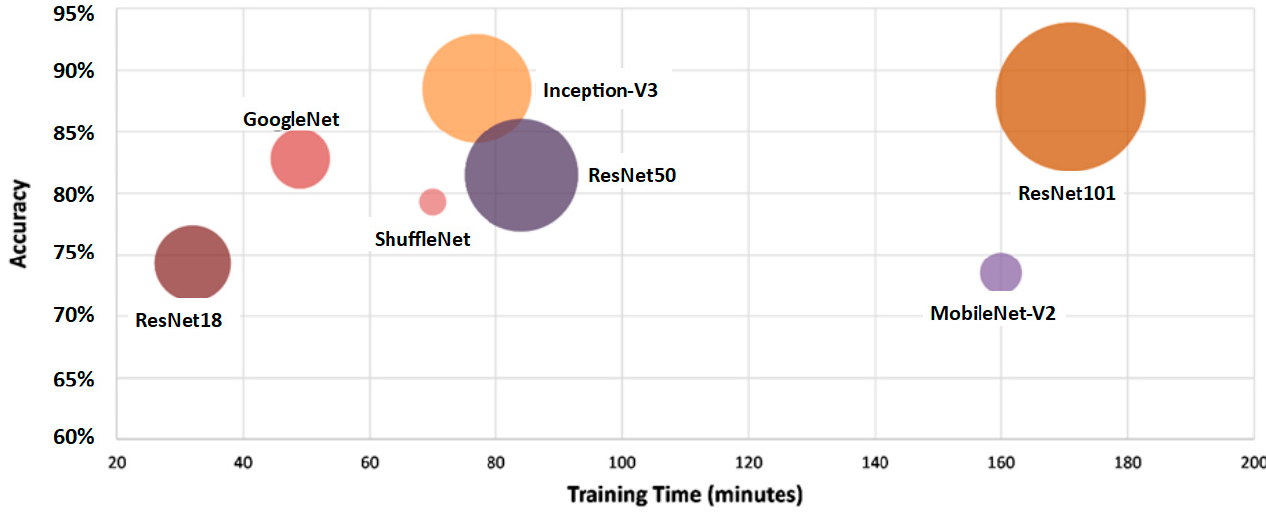
Figure 5. Accuracy vs. training time vs. size of model.